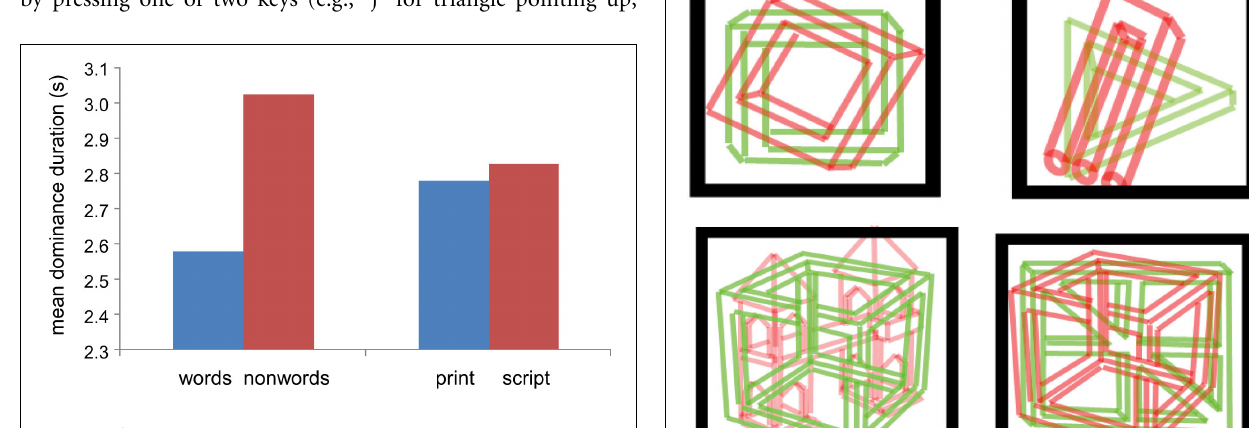
FIGURE 2 | Dominance durations. Mean dominance duration for non-words is greater than for words; no difference between print and script font. Pooled results for all subjects.